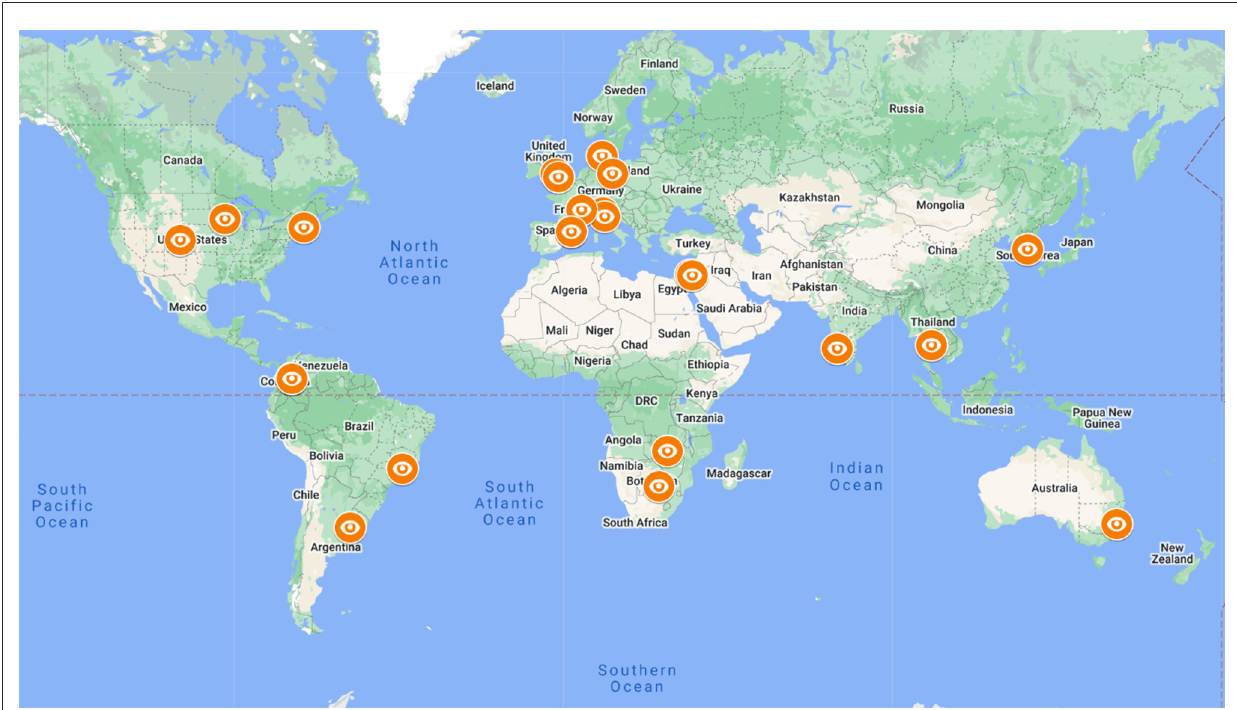
FIGURE1 Participating ACON centers. Twenty-eight ACON centers (status 10/2022) Africa (Botswana, Zambia), Asia (India, Korea, Thailand, Vietnam), the Middle East (Israel), North America (USA), South America (Argentina, Brazil, Colombia), Australia, and Europe (Denmark, France, Germany, Italy, Spain, United